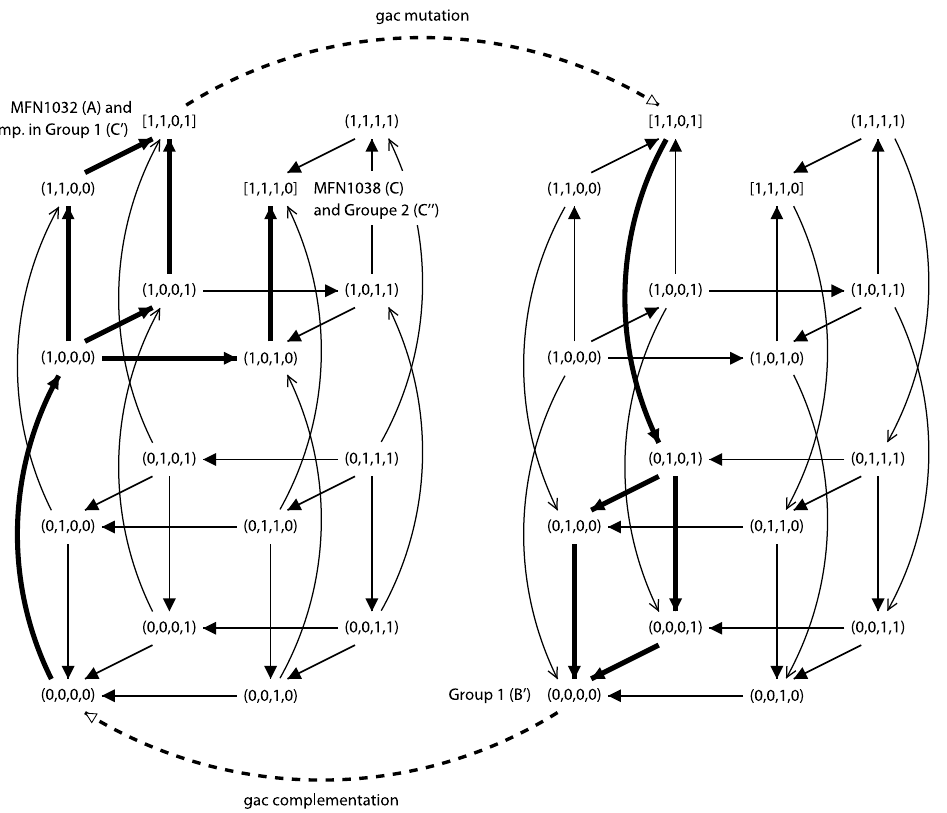
Figure 5. Illustration of property P ’ on the consistent network of Figure 3. Asynchronous state graphs are represented in a 4D-grid, as in Figure 3. The left graph described the dynamics of network of Figure 3. The right graph described the dynamics of this network under gac mutation. Stable states A and C ’ correspond to strains MFN1032 and group 1 variants complemented by gacA or gacS gene, stable state B ’ corresponds to group 1 variants, and stable states C corresponds to strains MFN1038 and group 2 variants. Dotted arrows represent the effect of mutation or complementation in gac . Bold lines represent trajectories followed by the systems.